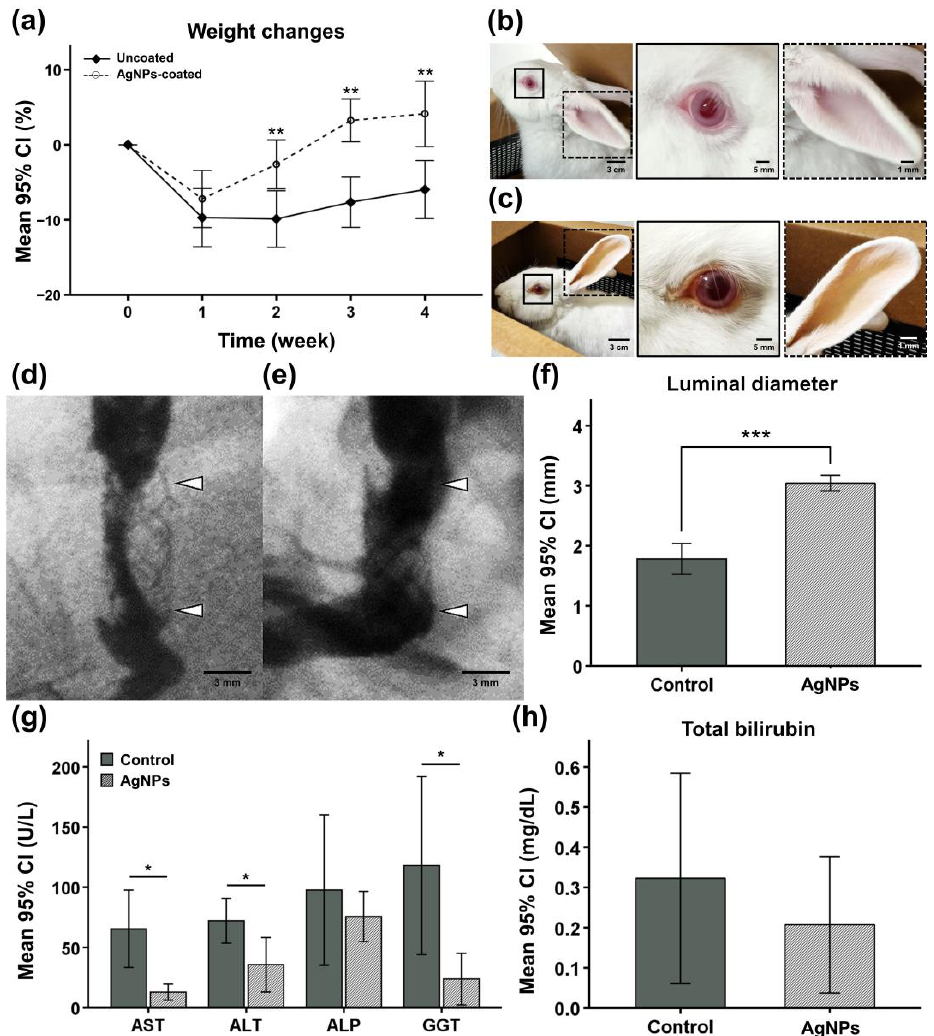
Figure 4. Procedural outcomes, cholangiography results, and hematological findings at 4 weeks after RF ablation with stent placement. ( a ) All rabbits recovered the weight loss caused by the procedure, and the recovery rate of the AgNPs group was significantly higher than of the control group. Compared with ( b ) normal rabbits, rabbits with ( c ) jaundice had yellow eyes (solid line square, magnification ×4.3) and ears (dashed line square, magnification ×23.1), and jaundice occurred only in the control group. The ( d ) uncoated SEMS (arrowheads) after RF ablation had a lower patency than the ( e ) AgNPs-coated SEMS (arrowheads). ( f ) Mean luminal diameter of the stented extrahepatic bile duct. ( g ) Mean levels of AST, ALT, ALP, GGT, and ( h ) total bilirubin in the two groups. CI, confidence interval; AST, aspartate transaminase; ALT, alanine aminotransferase; ALP, alkaline phosphatase; GGT, gamma ( γ )-glutamyl transferase; * p < 0.05, ** p < 0.01, *** p <